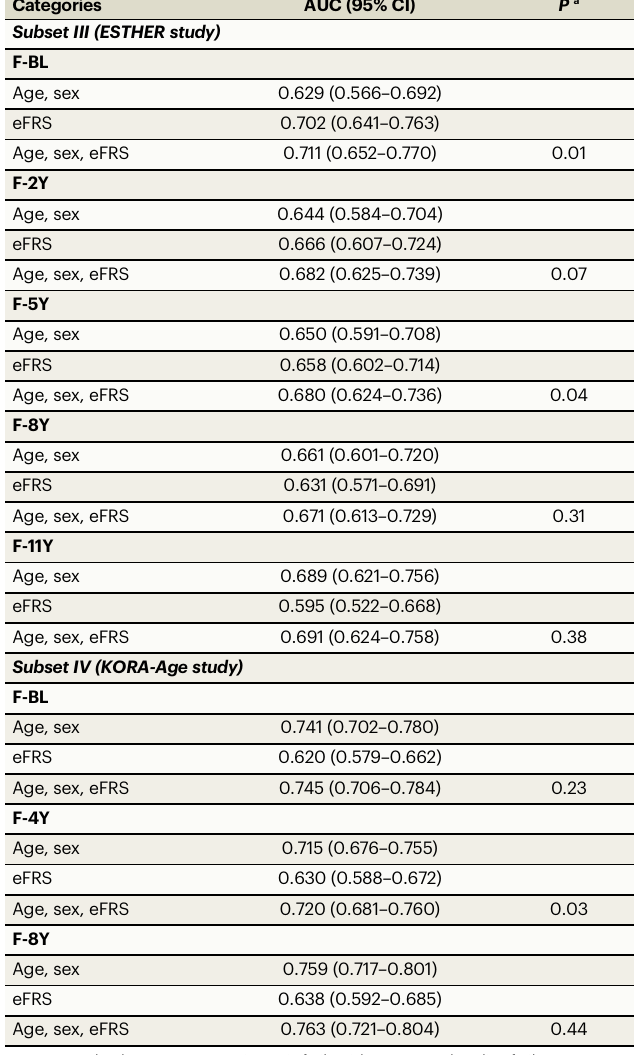
Table 3 | AUC (95% CI) of chronological age, sex, and epige- netic frailty risk score in prediction of being frail at baseline and each